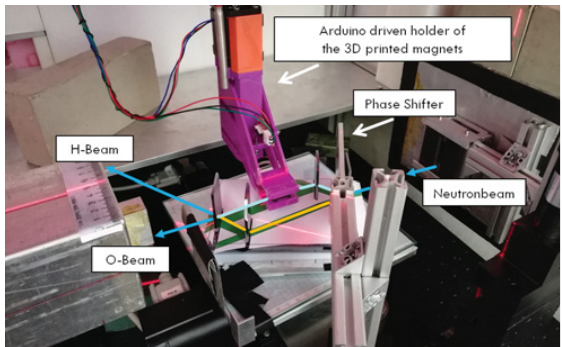
Figure 8. Photograph with illustration of the neutron beam splitting in the interferometric setup. The initial neutron beam is unpolarized. The spin flipper alters the phase of the wave function in path II (cyan) but not in path I (orange). After recombination, the intensity is measured in the forward direction ( O beam). Interferograms are be recorded as a function of an additional phase difference between the two paths, induced by rotating the phase shifter.